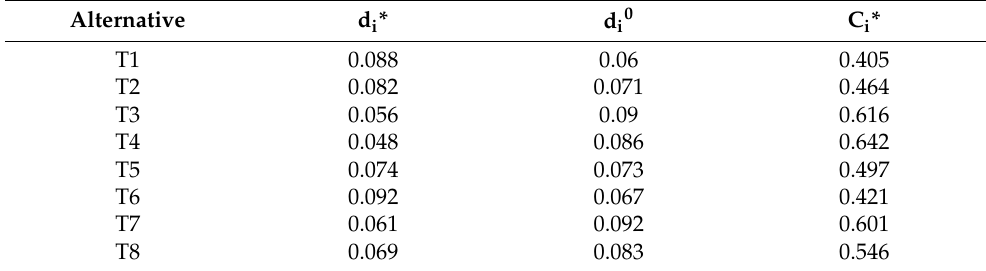
Table 23. TOPSIS result for all 8 candidate Business Process Modelling